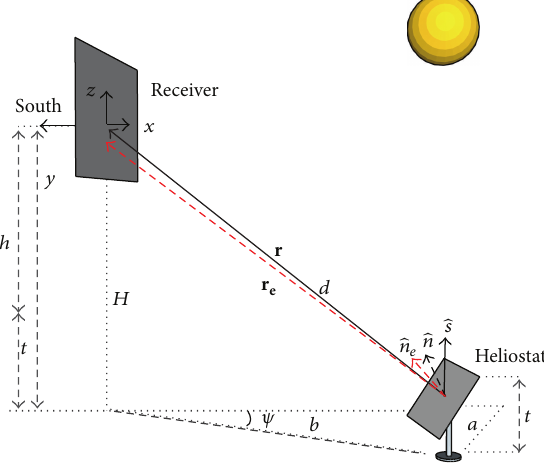
Figure 1: Geometry of the